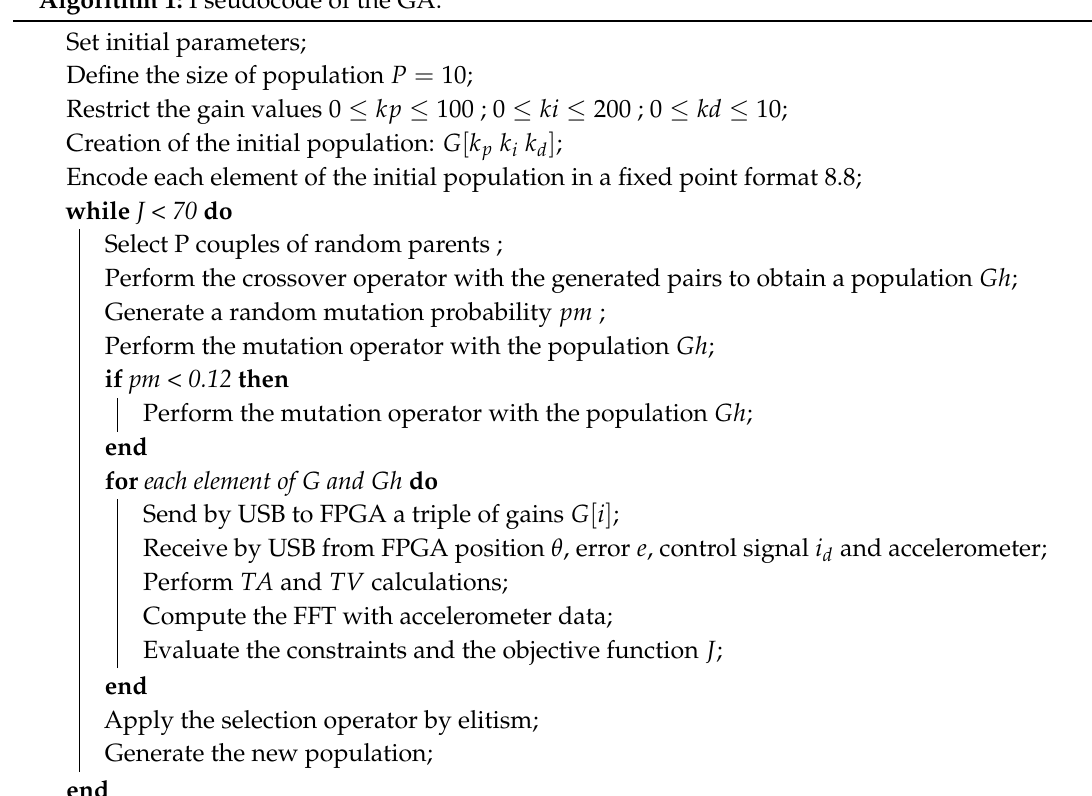
Algorithm 1: Pseudocode of the